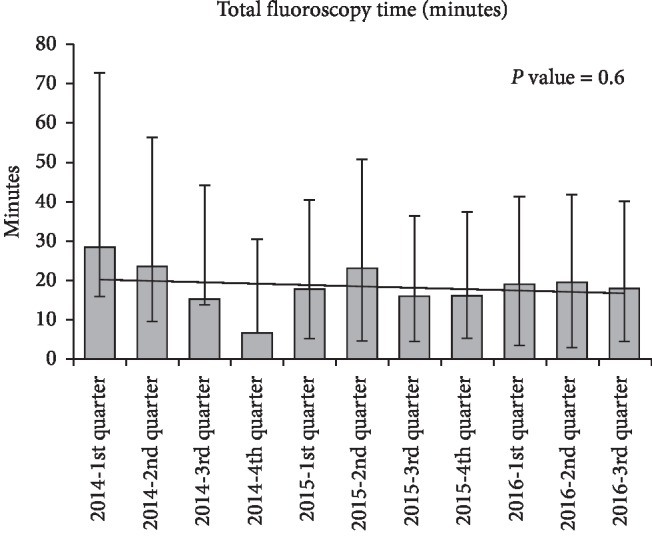
Quarterly total fluoroscopy time trends. P value = 0.6.